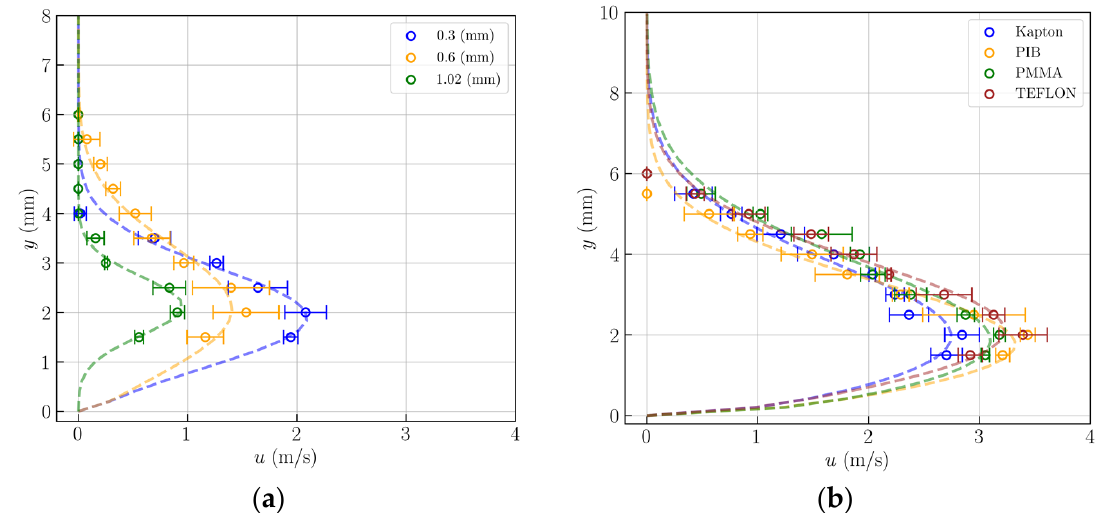
Figure 5. Induced flow velocity profiles obtained for different plasma actuators operating at a fre- quency of 24 kHz for actuators made of ( a ) Kapton with different dielectric thicknesses operating at 7 kV pp ; ( b ) different dielectric materials with 1 mm of thickness operating at 9 kV pp .